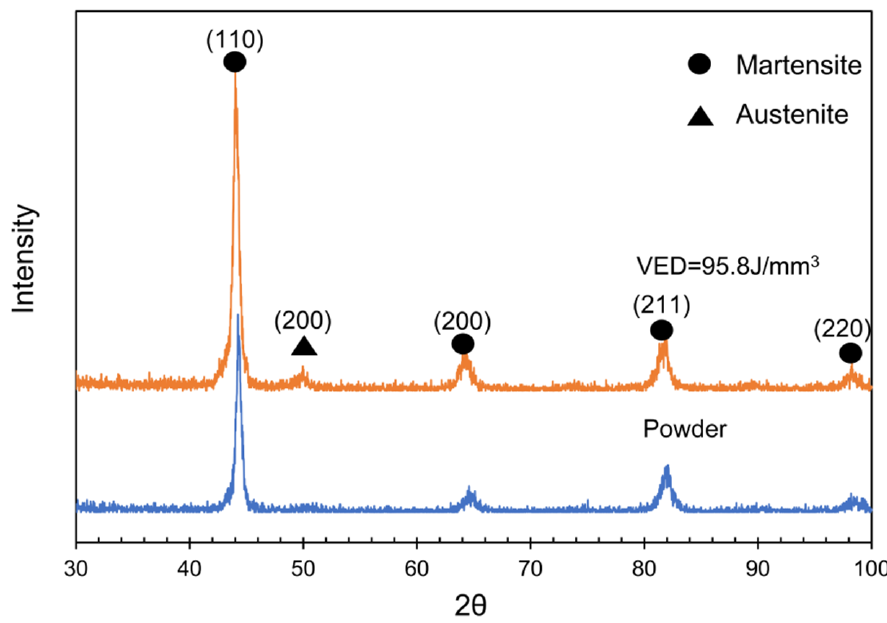
7 of 16 Figure 7. ( a ) SEM micrographs showing the unmelted and microvoids on fracture of tensile speci- mens possessed at the VED of 95.8 J/mm 3 ; ( b ) Detailed fracture morphology showing fine dimples. 3.2. Microstructural Characterization Figure 8 shows the XRD spectra obtained from H13 powder and as-SLMed H13 spec- imens at the VED of 95.8 J/mm 3 . The XRD patterns only presented the peaks of bcc-struc-